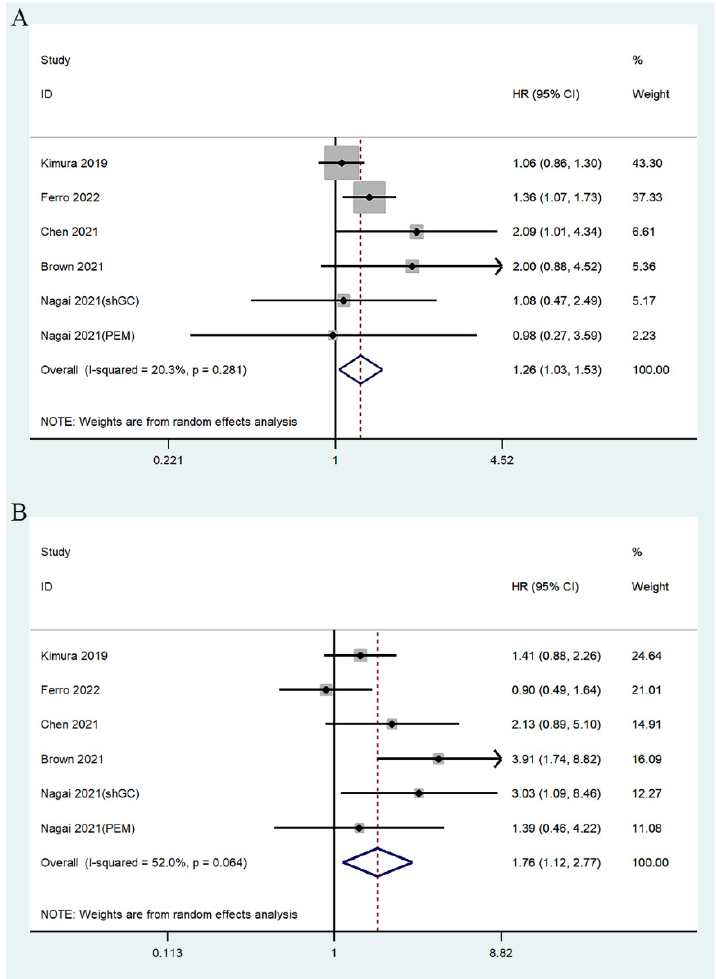
Figure 4. Forest plots of relationship between mGPS and PFS in patients with urothelial carcinoma: ( A ) mGPS 1 vs. 0; ( B ) mGPS 2 vs. 0 [24,29,30,32,33].